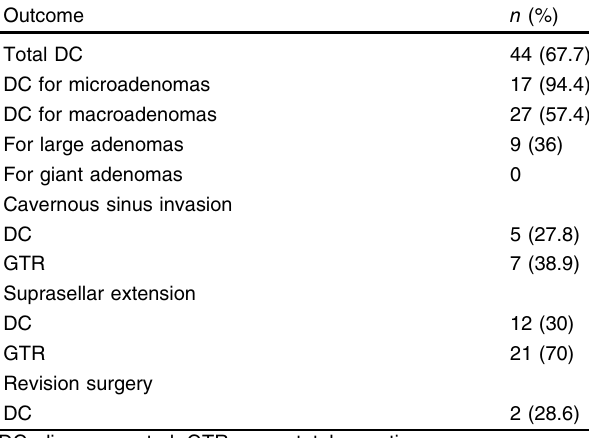
Table 2 General surgical outcome for the whole series